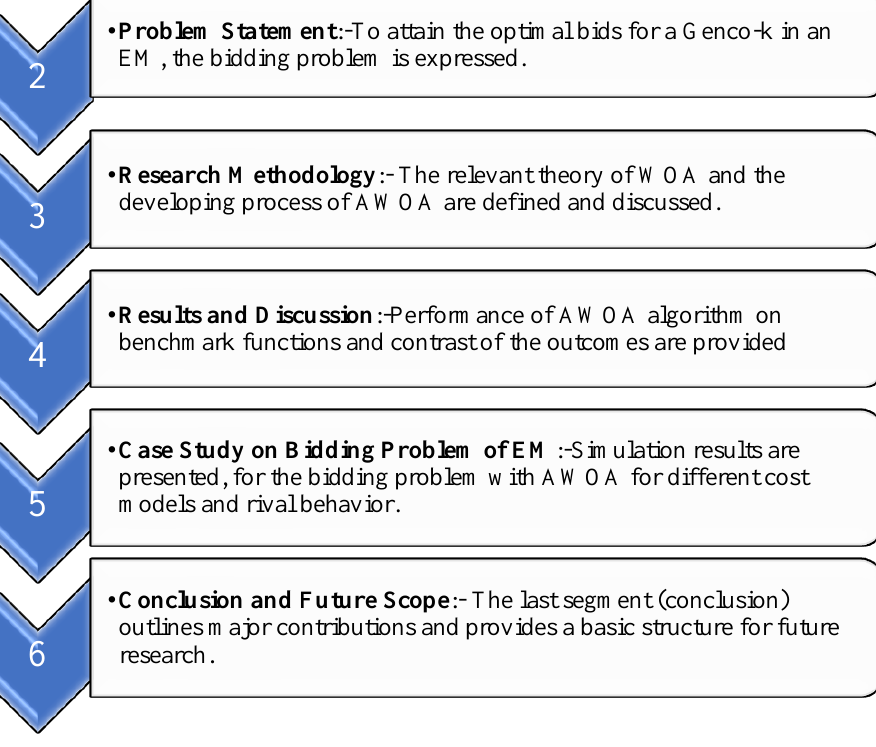
Figure 1. Paper Contribution Chart.